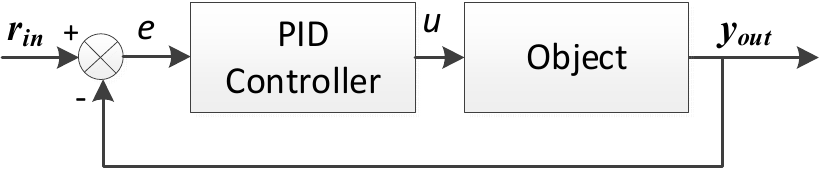
Figure 1. System structure of classical proportion integration differentiation (PID) control systems.